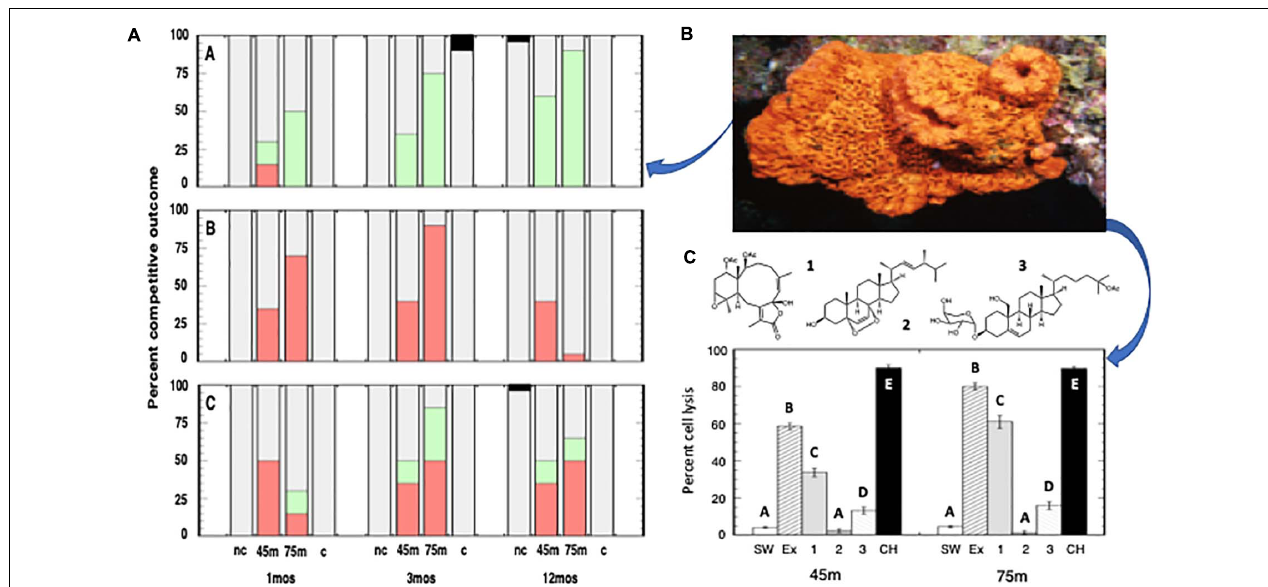
FIGURE 5 | (A) Field contact interactions between the gorgonian Ellisella elongata , and three sponge species: (A) Agelas cathrodes , (B) Plakortis angulospiculatus , and (C) Xestospongia muta . Competitive outcomes, assessed at 1 mo, 3 mo, and 12 mo, included overgrowth, tissue necrosis, and/or mortality of either the gorgonian or the sponge (red: sponge wins; green: gorgonian wins; grey: draw; black: undetermined cause of mortality in a control). Histograms represent replicate ( n = 12) interactions and include gorgonians from 45 m in contact with sponges, gorgonians from 75 m in contact with sponges, contact controls (“c”: dead gorgonian in contact with sponges), and non-contact controls (“nc”: sponges alone). (B) Agelas clathrodes , a common sponge of MCEs and a model for our field and laboratory assays. (C) Allelopathic responses of the sponge Agelas clathrodes to the gorgonian Ellisella elongata from 45 m and 75 m. Histograms represent the mean ± SE percent sponge cells lysed ( n = 4 replicates) in response to either controls (SW: calcium-/magnesium-free filtered seawater; CH: CHAPS) or Ellisella elongata extract (EX) and three E. elongata compounds at ecologically relevant concentrations. Similar superscripts represent treatment groups not significantly different from each other (Tukey’s HSD: P >